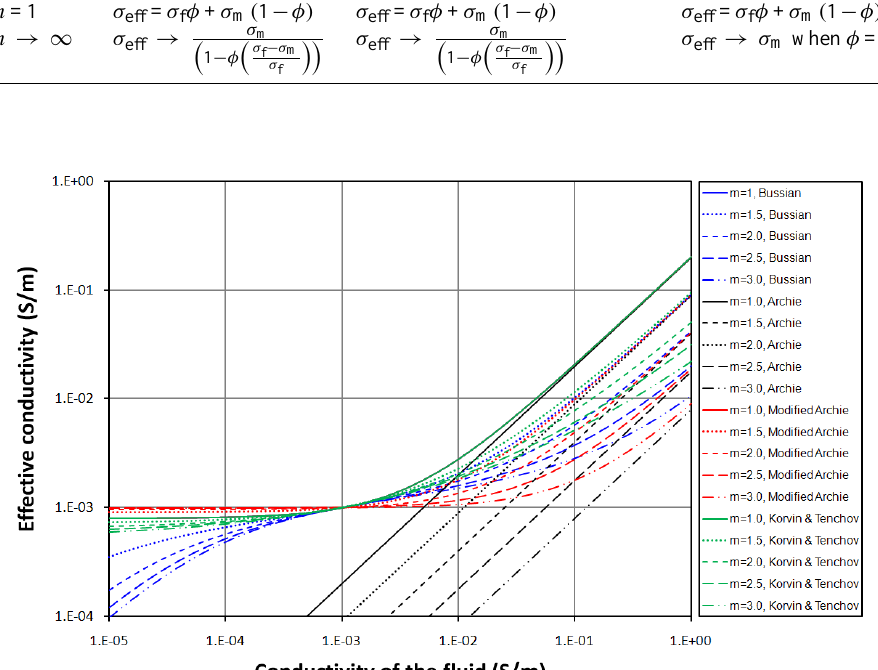
Fig. 2. Effective electrical conductivity σ eff calculated as a function of porosity at 1001 points for the Bussian equation (blue) using the conformal mapping method, Archie’s law (black), Modified Archie’s law (red) and the model of Korvin and Tenchov (green); all for φ =0.2; m =1, 1.5, 2, 2.5, 3; σ m =10 − 3 S/m; 10 − 5 S/m ≤ σ f ≤ 1S/m). Note that all methods except Archie’s law converge at σ eff = σ f =10 − 3